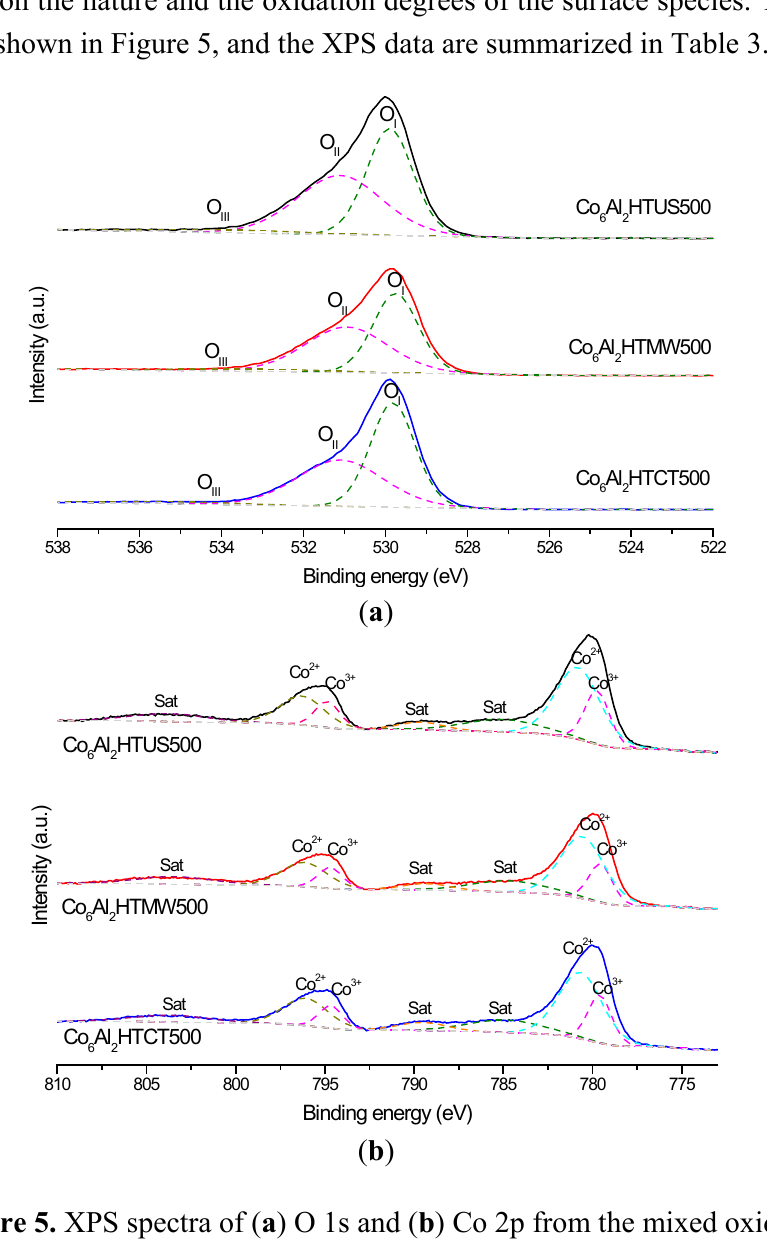
Figure 5. XPS spectra of ( a ) O 1s and ( b ) Co 2p from the mixed